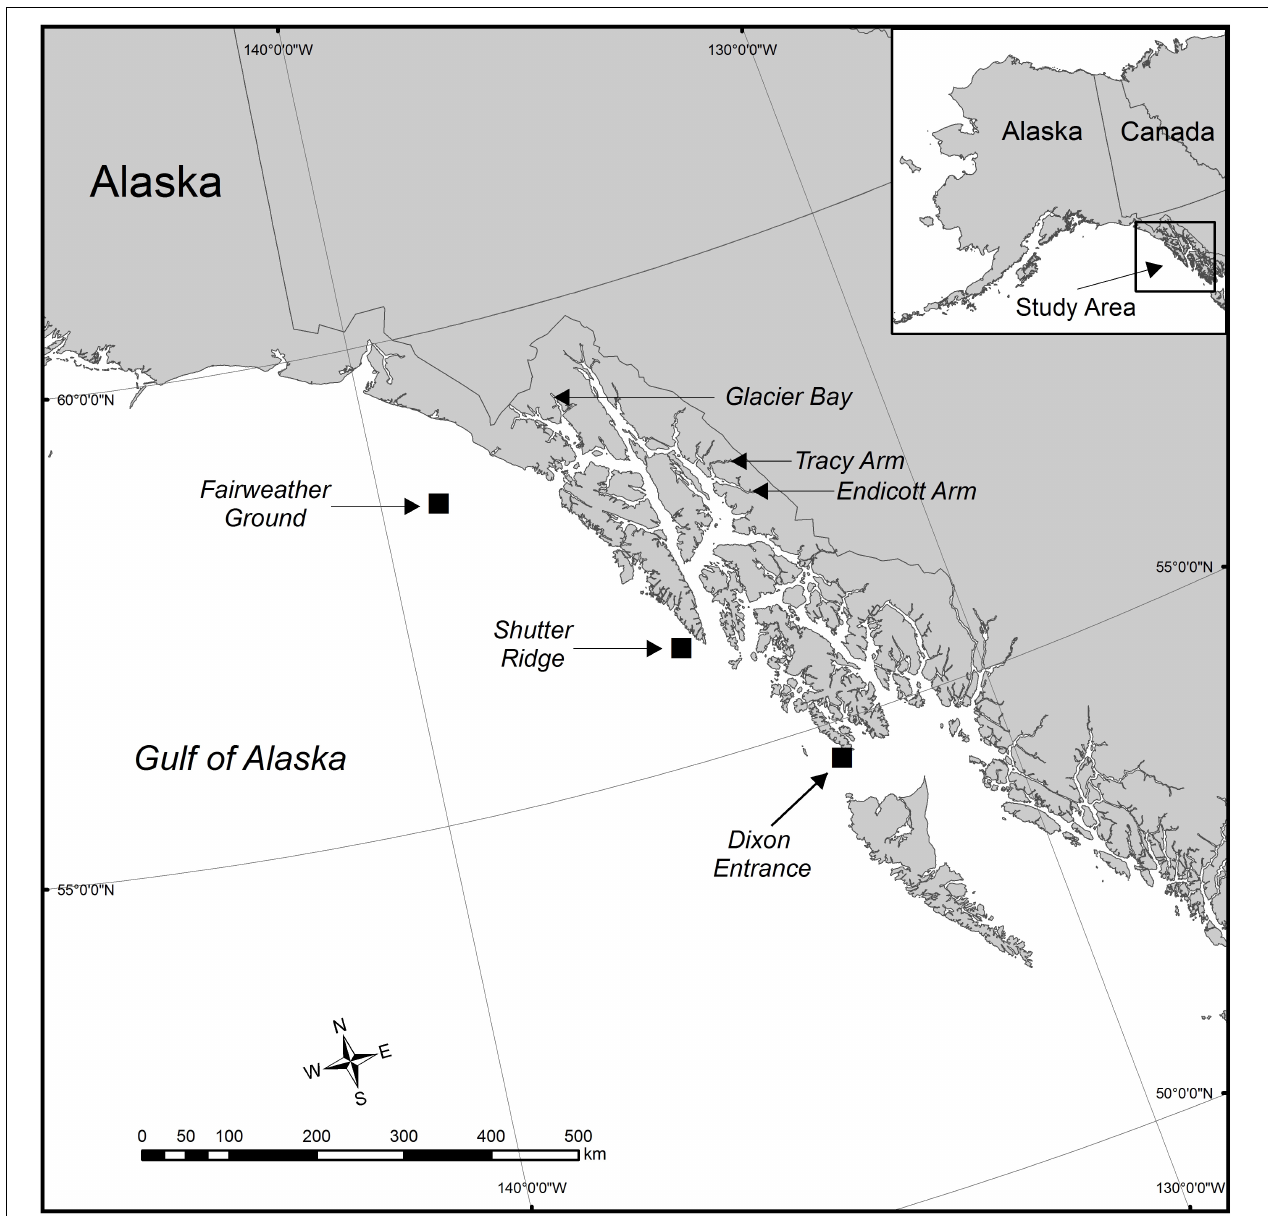
FIGURE 1 | The study area in the eastern Gulf of Alaska showing the six geographical locations where red tree coral samples were collected. Eight data sets were generated from these six collection locations. Samples were collected in Glacier Bay at the same site (latitude and longitude) but at two distinct depth zones. At the Tracy Arm site, samples were collected during two distinct seasons (June and January). Squares show areas of deep